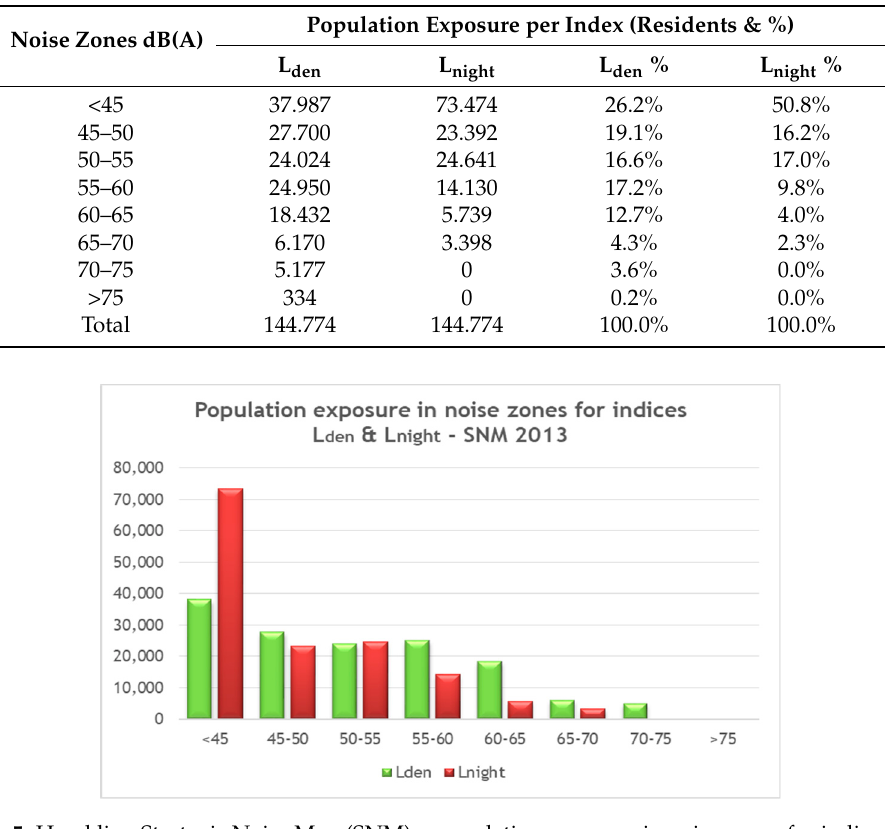
Table 2. Strategic Noise Map of Corfu—Population exposure in noise zones of airport noise.